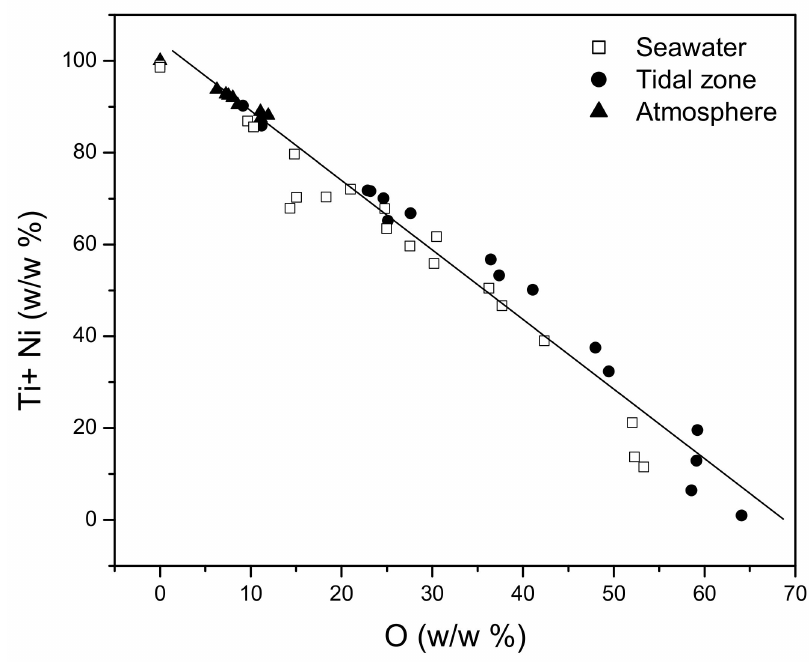
Figure 12. The change in the total content of metals in the function of oxygen content. PCA forms principal components as a linear combination of the original variables, and recognises and excludes redundant data that do not contain new information and encumber the analysed system. For these reasons, PC1, as the first principal component, should describe the corrosion of the analysed NiTi disc prevalently in all types of environ- ments. The obtained PC1 values for all types of environments were correlated with the oxygen content obtained by means of the EDX analysis (Figure 13) in order to confirm the previous